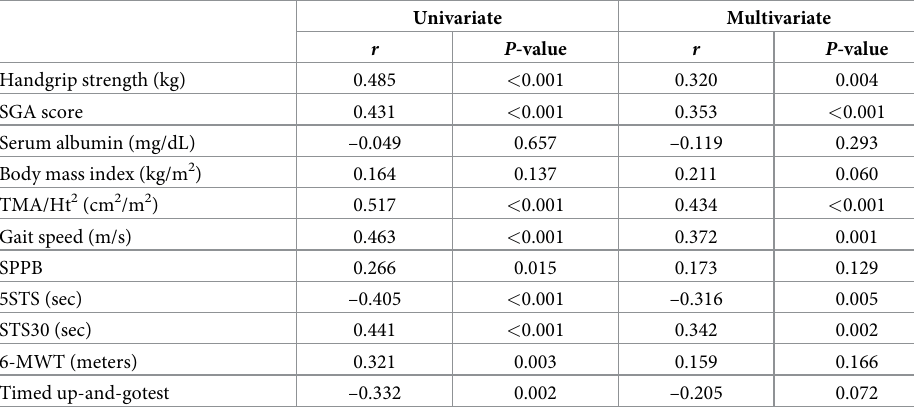
Table 3. Correlation between phase angle and various indices.